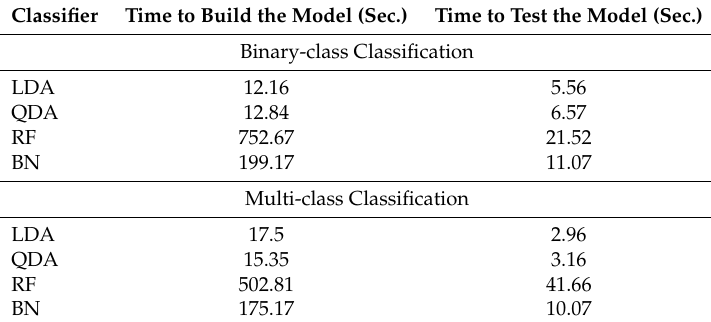
Table 15. Time to build and test the